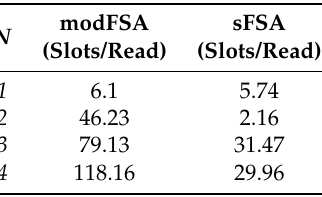
Table 1. Comparison of the number of slots needed to read one tag between the modFSA and the sFSA.